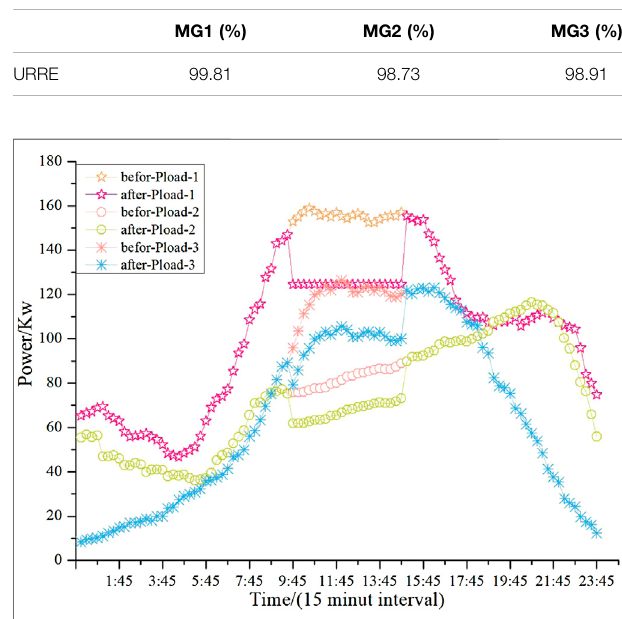
FIGURE 10 | Bi-level planning fl exible load